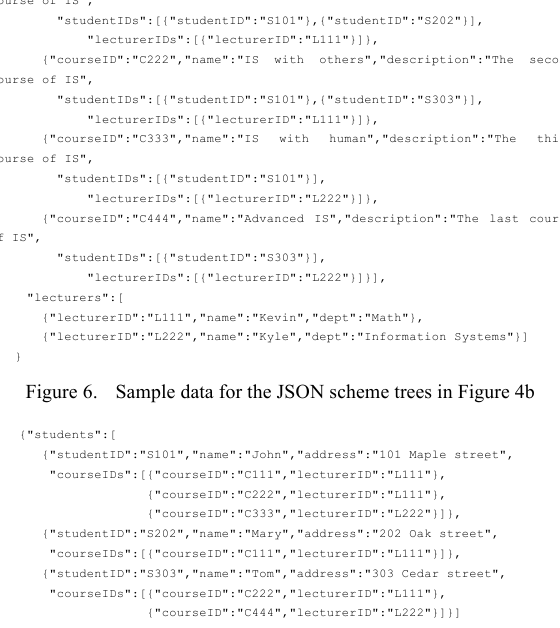
Figure 5. Sample data for the JSON scheme trees in Figure 4a